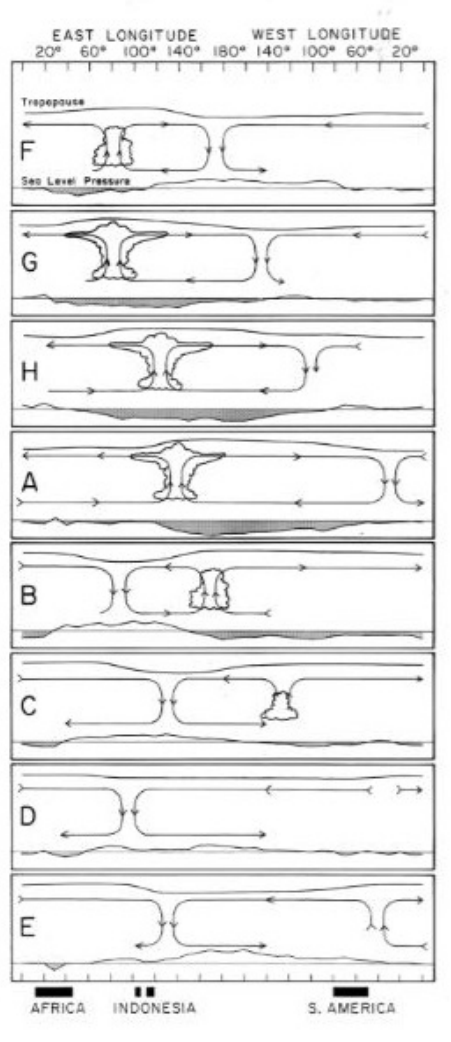
Figure 7. Schematic depiction of the time and space variations in the oscillation. Phase A (E) is the time of lowest (highest) pres- sure at Kanton Island. Other phases are intermediate times and, for a 48d period, are approximately 6d apart. Anomaly pressures are indicated at the bottom of each panel, with negative anomalies shaded. Circulation cells are based on u -wind variations. Regions of enhanced convection are proposed based on u -wind convergence/di- vergence, tropopause height differences (top line), and mixing ratio